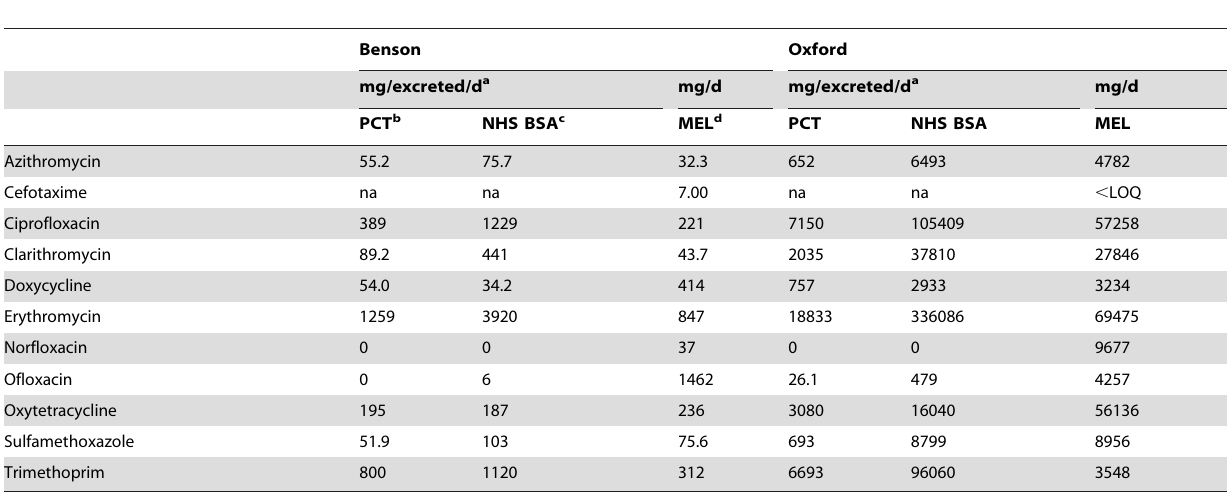
Table 3. Comparison of measured environmental load (MEL) of antibiotics in WWTP influent to MEL estimates generated from PCT- and NHS BSA-derived